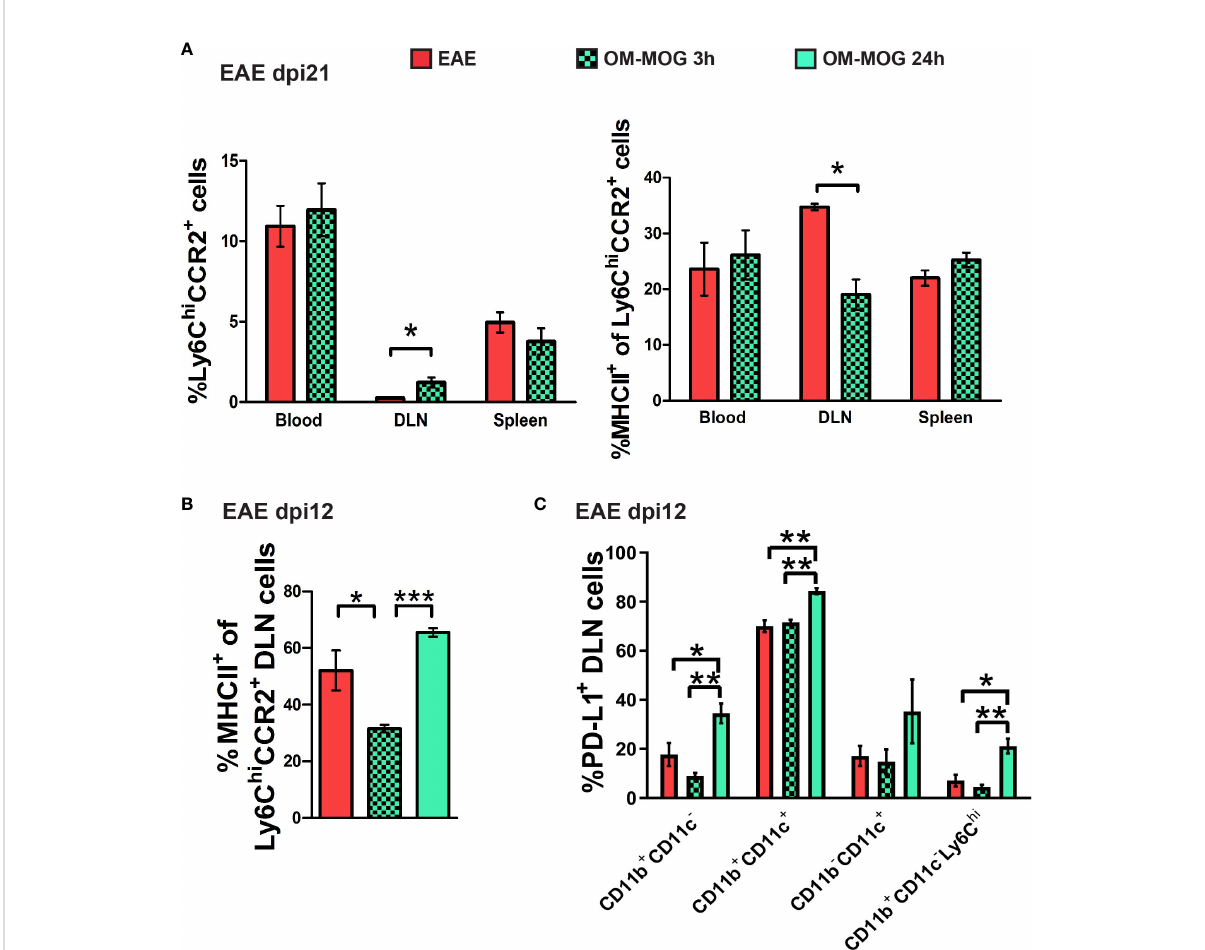
FIGURE 7 Soluble OM-MOG retains and activates Ly6C hi CCR2 + monocytes in the skin DLN: (A) Proportions of Ly6C hi CCR2 + monocytes (left graph), and Ly6C hi CCR2 + monocytes expressing MHCII (right graph) in blood, spleen and draining inguinal LN (DLN) of EAE mice 3 h after a single therapeutic i.d. injection of vehicle (EAE control) or OM-MOG (n=4/group). (B) Proportions of Ly6C hi CCR2 + monocytes expressing MHCII in the DLN of EAE mice 3 h and 24 h after a single therapeutic i.d. injection of vehicle (EAE control) or OM-MOG (n=3/group). (C) Proportions of PD- L1-producing CD11b + CD11c - , CD11b + CD11c + (myeloid DC), CD11b - CD11c + (DC) and CD11b + CD11c - Ly6C hi cells in the DLN of EAE mice 3 h and 24 h after a single therapeutic i.d. injection of vehicle (EAE control) or OM-MOG, as in B (n=3/group). Data and statistical analysis are from one (B, C) or one of 2 independent experiments (A) . Statistical signi fi cance is shown after comparisons between groups using Mann-Whitney test (A) , or one-way ANOVA followed by Tukey ’ s post hoc test (B, C) (*p ≤ 0.05, **p ≤ 0.01, ***p ≤